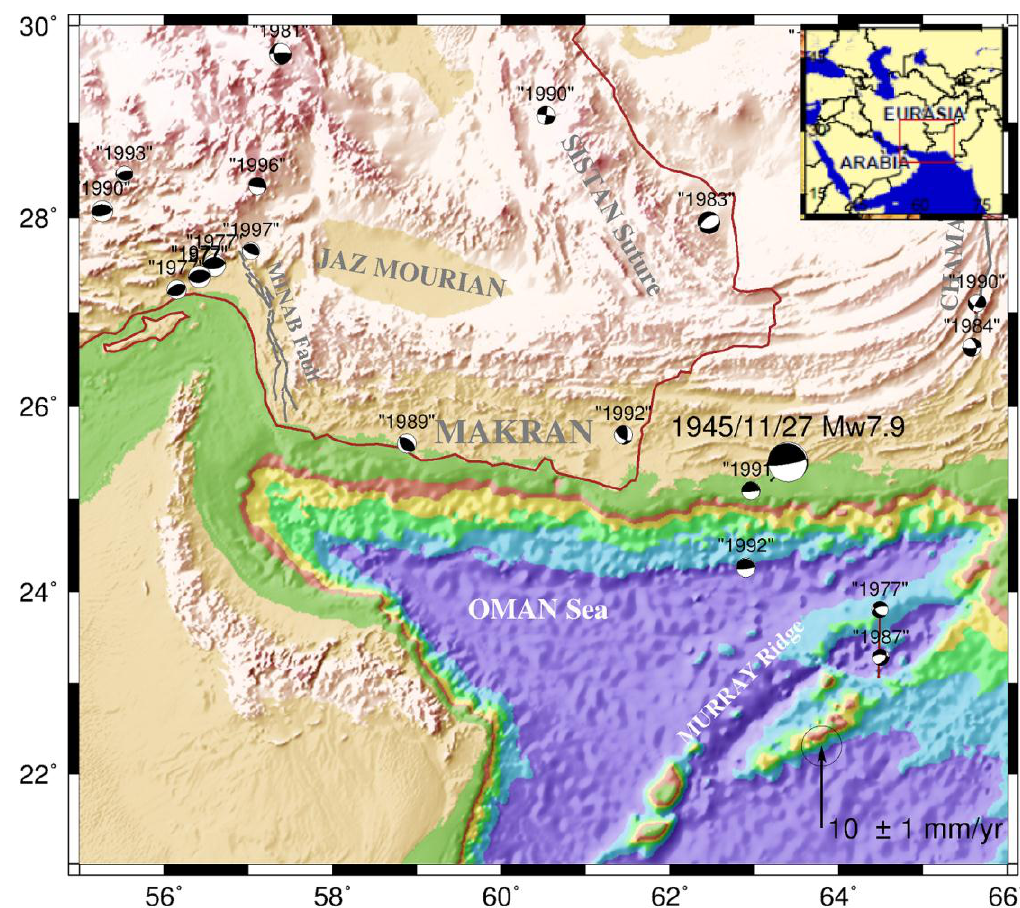
Figure 1. 3D topographic map of Makran region with a focal mechanism of earthquakes with Mw≥6 from Harvard’s catalogue (Dziewonski et al., 1983). The major fault zones are